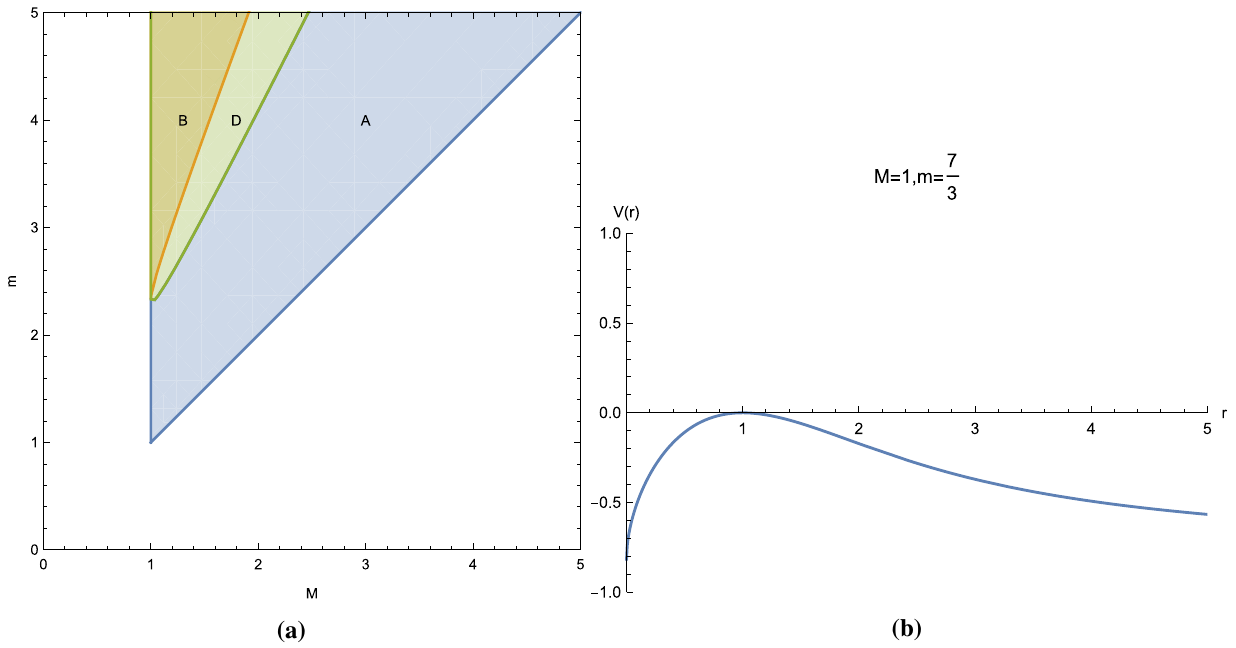
( a ) (b) Fig. 3 a The classifications of bouncing processes by different mass that the spherical shell locate at r = 1, where the position of horizon of } , which cor- parameters’ regions. b the V ( r ) profile of { M = 1 , m = 7 extremal black hole 3 responds to the intersection of region A , B , D of left diagram. It shows